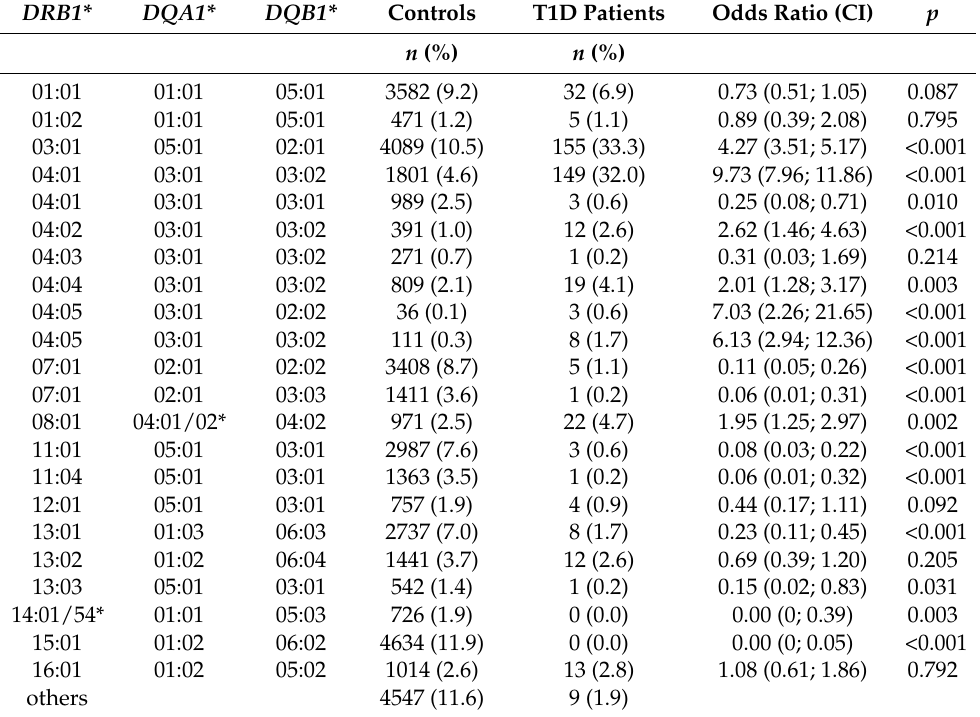
Table 1. DRB1-DQA1-DQB1 haplotype frequencies in controls and early-onset type 1 diabetes (T1D) patients and corresponding odds ratios to develop early-onset